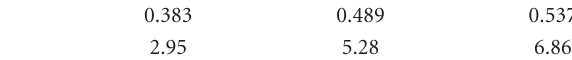
Table 2: Calculated Froude number versus Reynolds number for isolated jet. Froude number, Fr